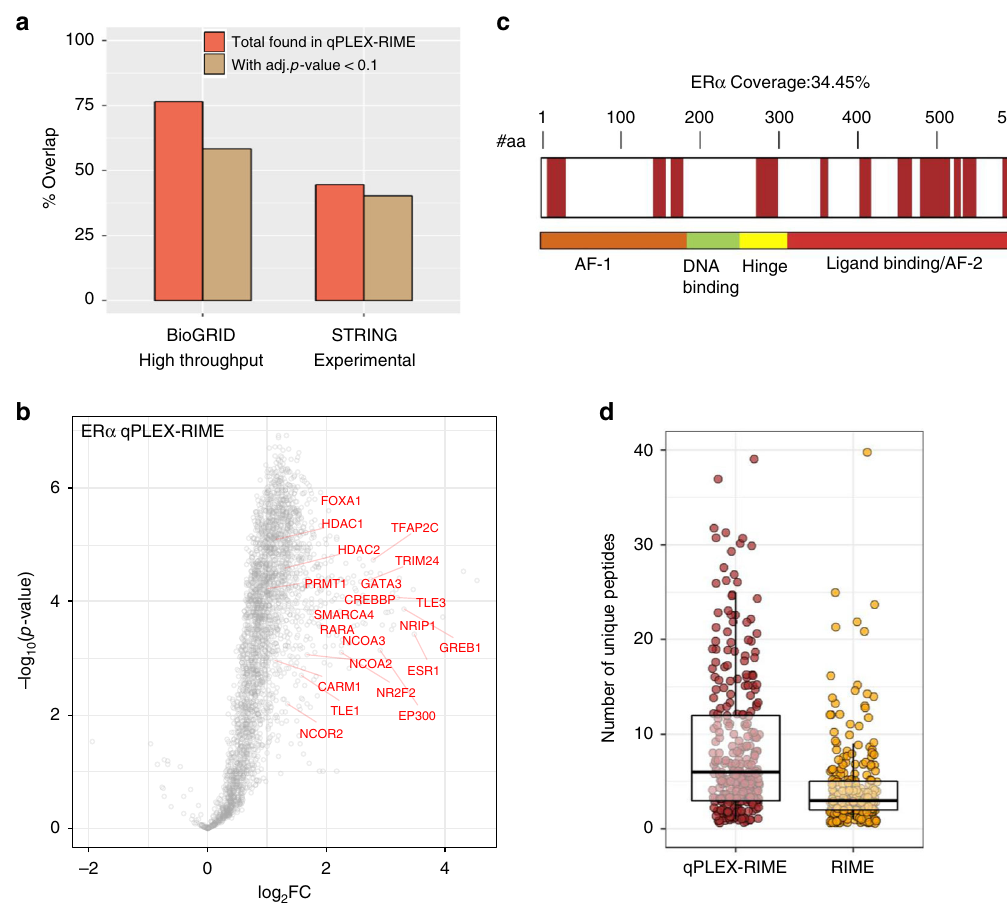
Fig. 2 Application of qPLEX-RIME for the identi fi cation of ER α -speci fi c interactors in breast cancer cell lines. a Bar plots illustrating the overlap of the qPLEX-RIME data with known ER α -associated proteins from BioGRID and STRING databases. b Volcano plot summarising the quantitative results of the ER α qPLEX-RIME. ER α and several of its known signi fi cantly enriched interactors are labelled. c Sequence coverage of the ER α protein in the qPLEX-RIME analysis. d Boxplots of the number of unique peptides for the overlapping ER α -associated proteins between the non-quantitative RIME and the qPLEX-RIME method. Centre line shows the median, bounds of box correspond to the fi rst and third quartiles and the upper and lower whiskers extend to the largest or the smallest value no further than 1.5 × IQR (inter-quartile